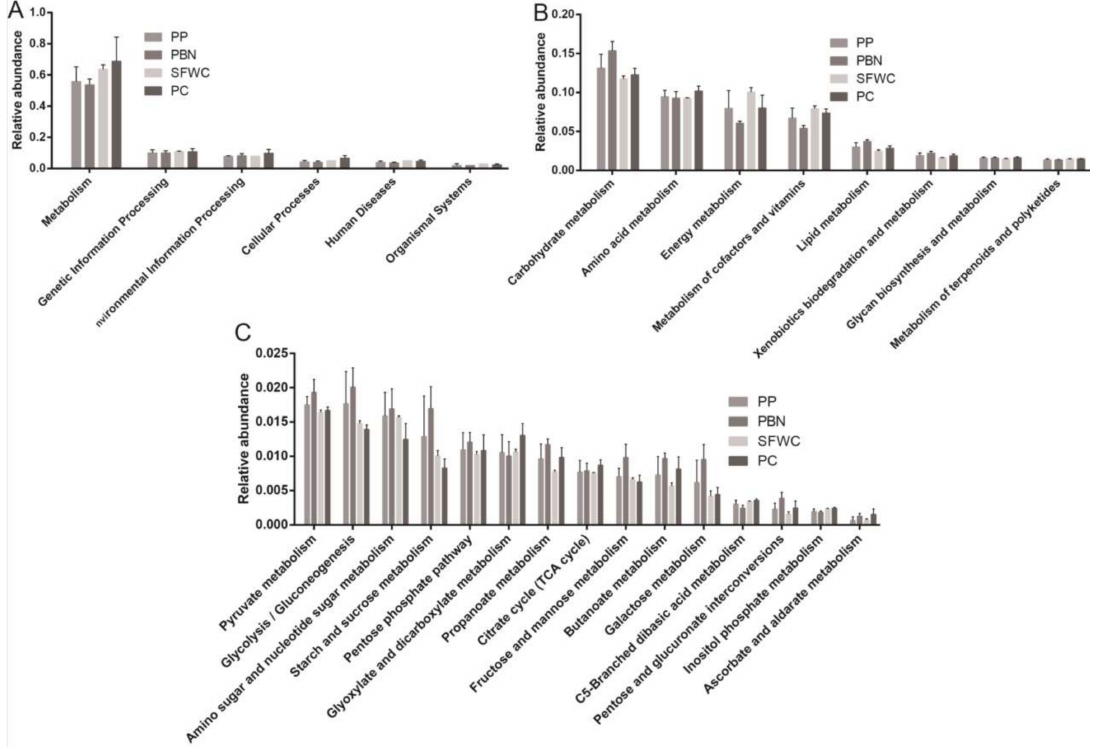
Figure 8. The predictive functions of the bacterial community in four traditional fermented vegetables samples. ( A ) Overall KEGG gene function statistics (Level 1). ( B ) The relative abundance of pathways in metabolism (Level 2). ( C ) The relative abundance of pathways in carbohydrate metabolism (Level